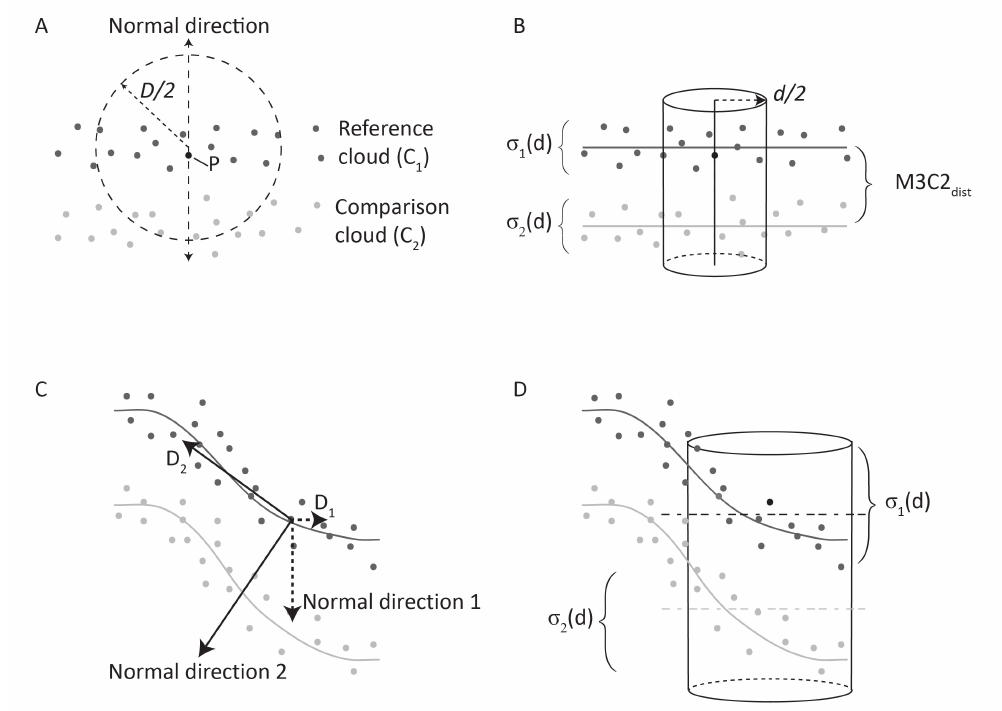
Figure 2. Illustration of the M3C2 algorithm adapted from Lague et al. [31]. ( A ) The normal direction to C 1 is computed based on a diameter, D. ( B ) Projection of the cylinder, diameter d, along normal direction to calculate distance between C 1 and C 2 . ( C ) Normal direction corresponding to a smaller, D 1 , and larger, D 2 , diameter. ( D ) Local roughness, σ d, can be higher in steep terrain, which influences the confidence value, C 95%